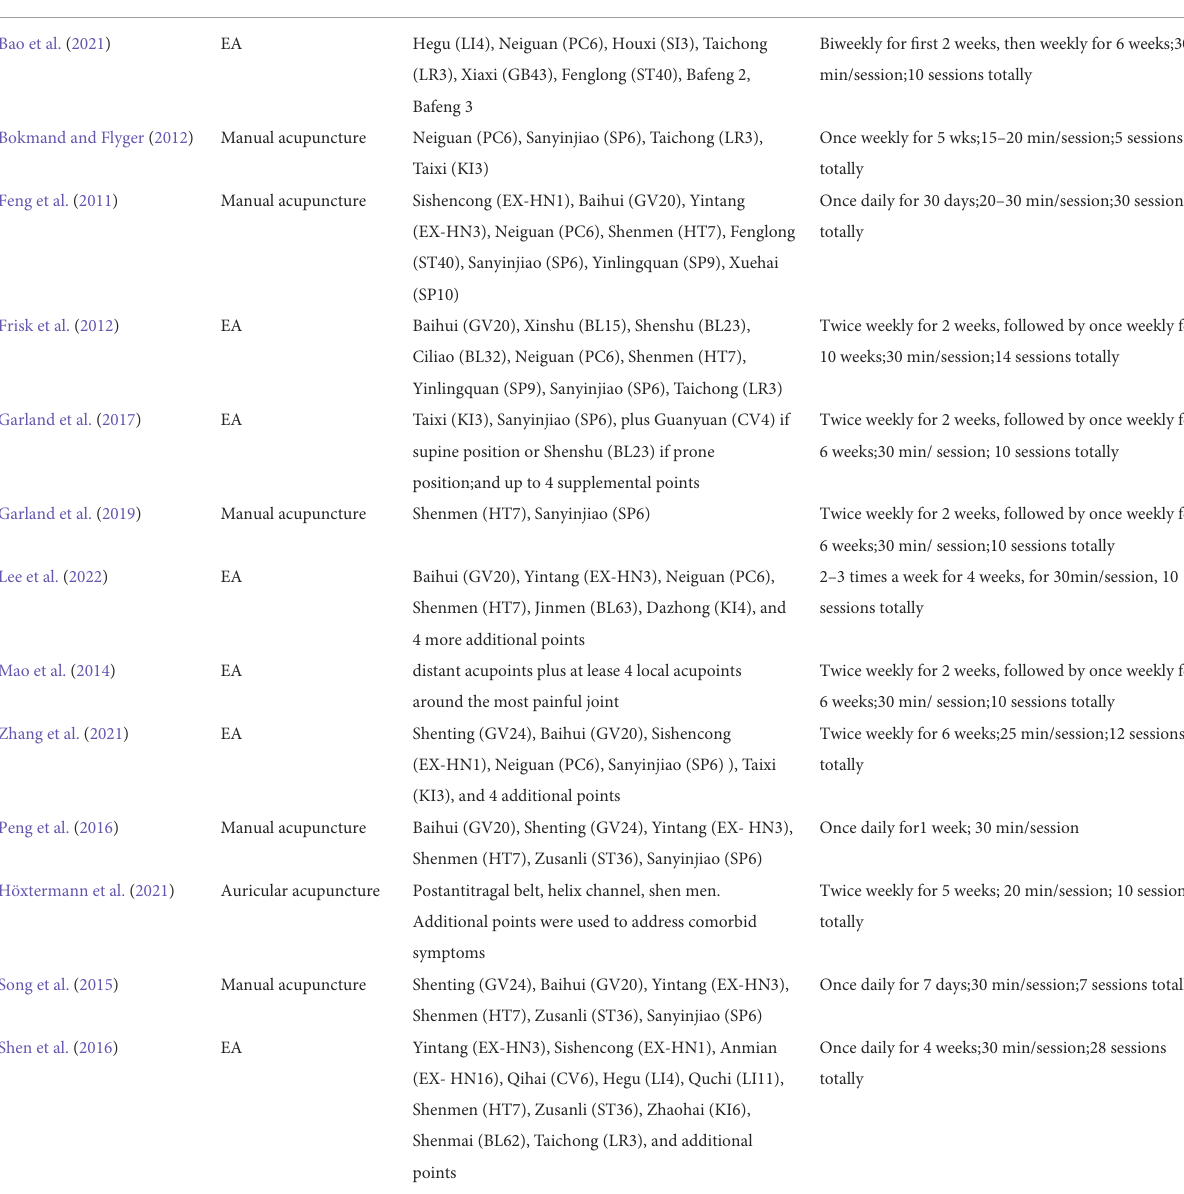
TABLE 2 Summary of acupuncture